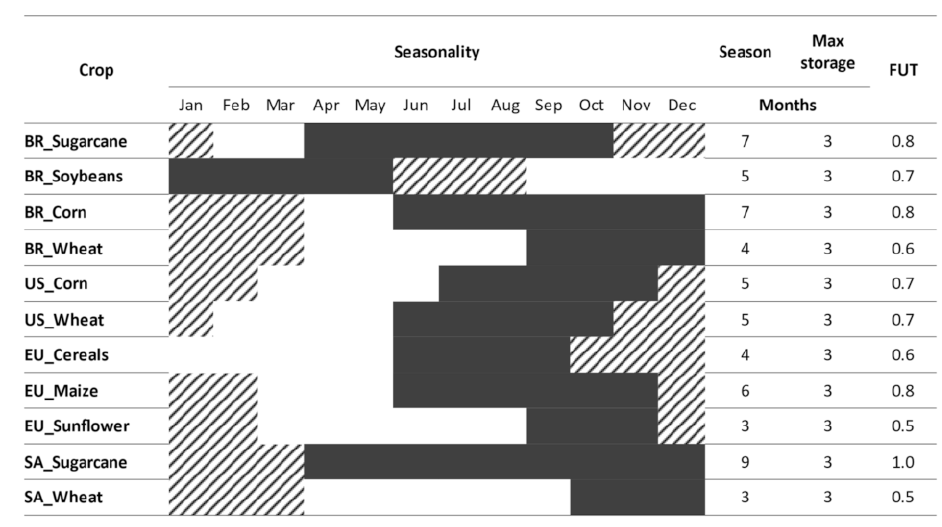
Figure 6. Crop’s seasonality, storage times, and FUT in each